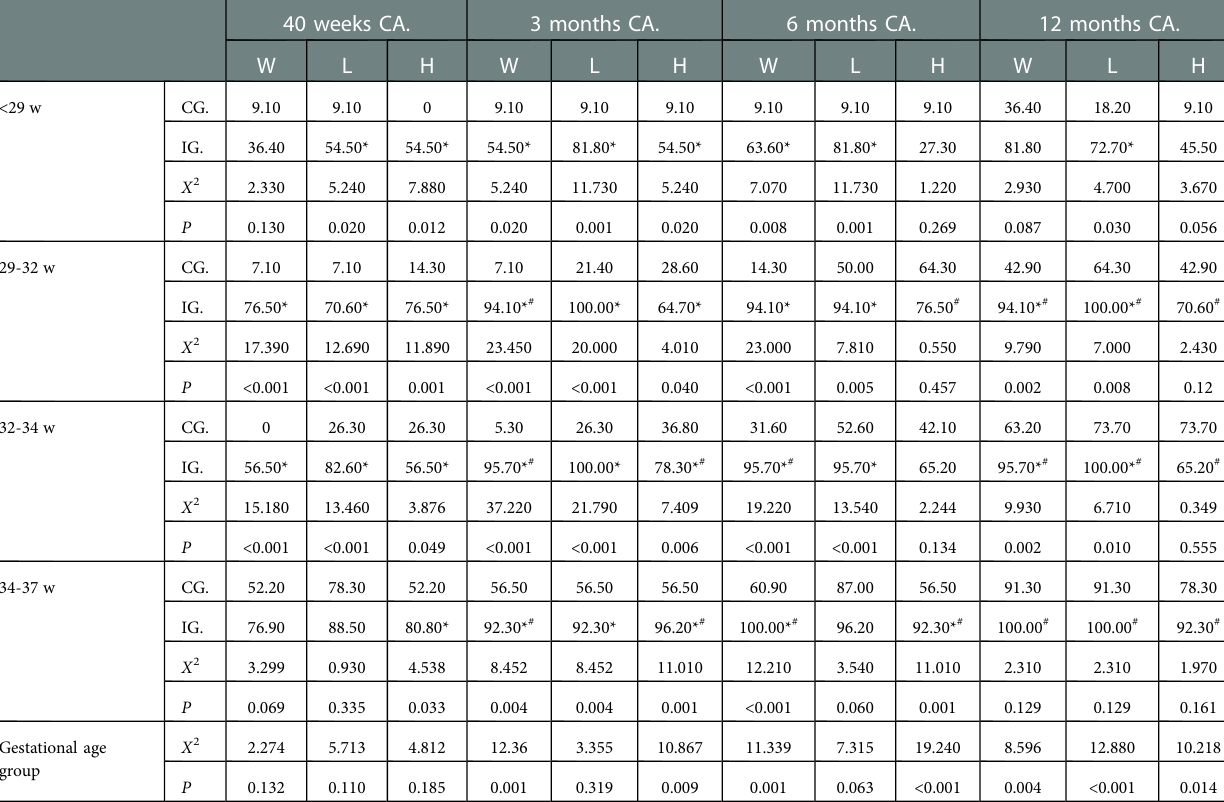
TABLE 7 Comparison of the satisfaction rate of physical development catch-up in different gestational age groups (%) group. 40 weeks CA. 3 months CA. 6 months CA. 12 months